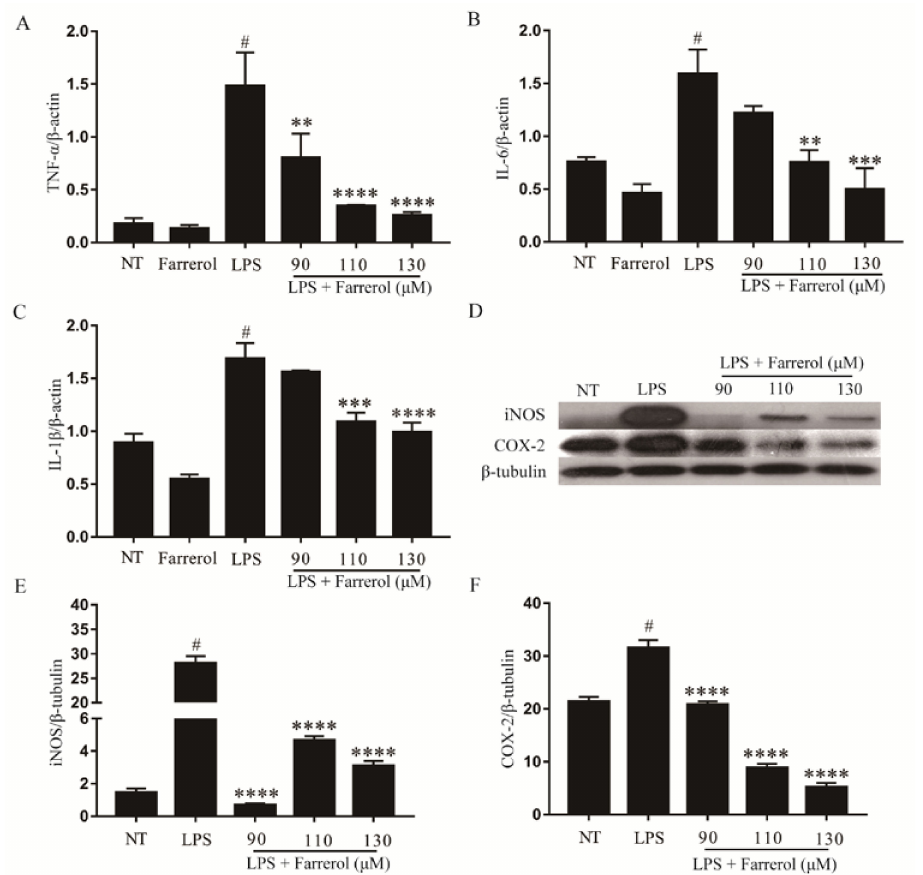
Figure 8. The effect of farrerol on pro-inflammatory mediator’s production in LPS-stimulated mMECs. MMECs were divided into six groups: NT group, Farrerol group, LPS group, LPS + farrerol (90, 110, 130 µ M) group. The mRNA levels of TNF- α ( A ); IL-6 ( B ) and IL-1 β ( C ) were measured by real-time PCR. The protein levels of iNOS ( D , E ) and COX-2 ( D , F ) were measured by Western blot. Data are presented as mean ± SEM ( n = 3). # p < 0.05 vs. NT group; ** p < 0.01, *** p < 0.001 and **** p < 0.0001 vs. LPS